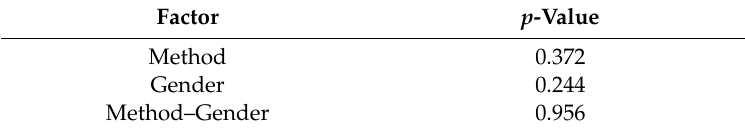
Table 2. p -Value obtained by performing a two-way analysis of variance (ANOVA) analysis.